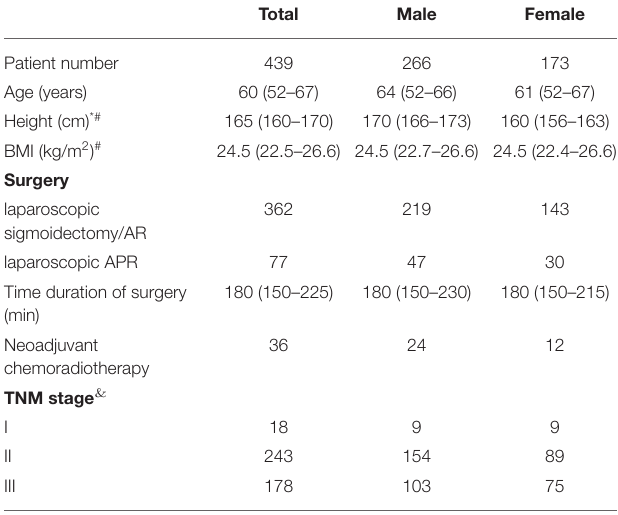
TABLE 1 | Baseline